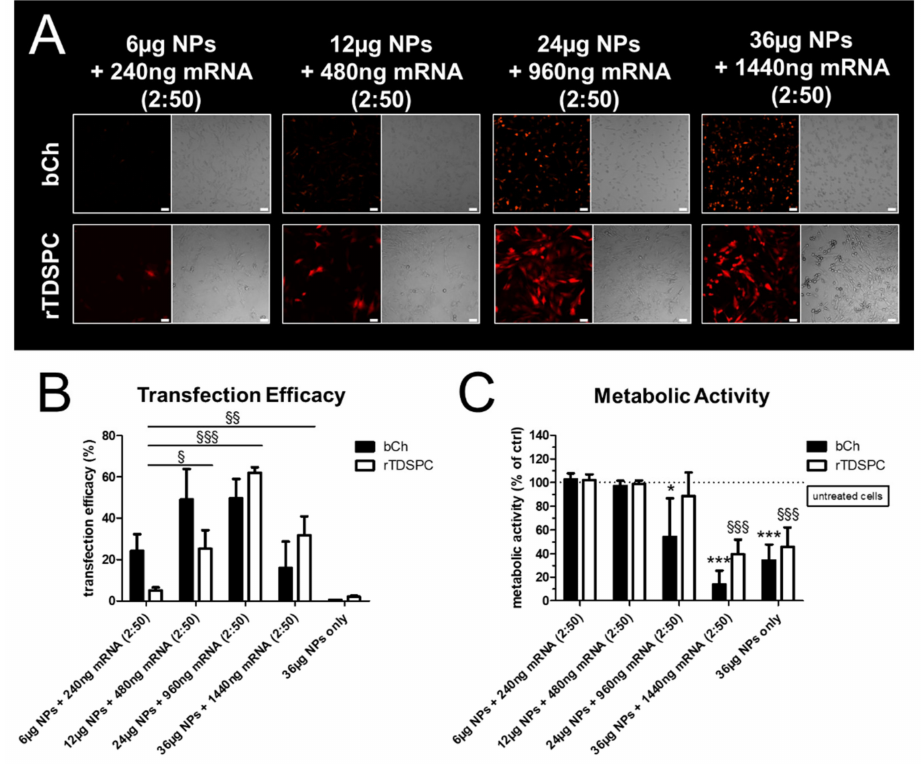
Figure 6. Treatment of bCH and rTDSPC with increasing amounts of the optimal mRNA:nanoparticle loading ratio 2:50. ( A ) Fluorescence and bright-field images of bCH and rTDSPC treated with the different formulations. Scale bar = 50 µ m. ( B ) Transfection efficiency analyzed with flow cytometry shown as % tdTomato-positive cells of the total population (ANOVA with Dunnet’s Multiple Comparison test using 6 µ g NPs [2:25] as a reference; n = 3). ( C ) Metabolic activity determined by Alamar Blue assay (ANOVA with Dunnet’s Multiple Comparison test using untreated cells as reference; n = 3). § used to indicate significance for rTDSPC, * for bCH. */ § p < 0.05, §§ p < 0.01, ***/ §§§ p < 0.001. ( n =